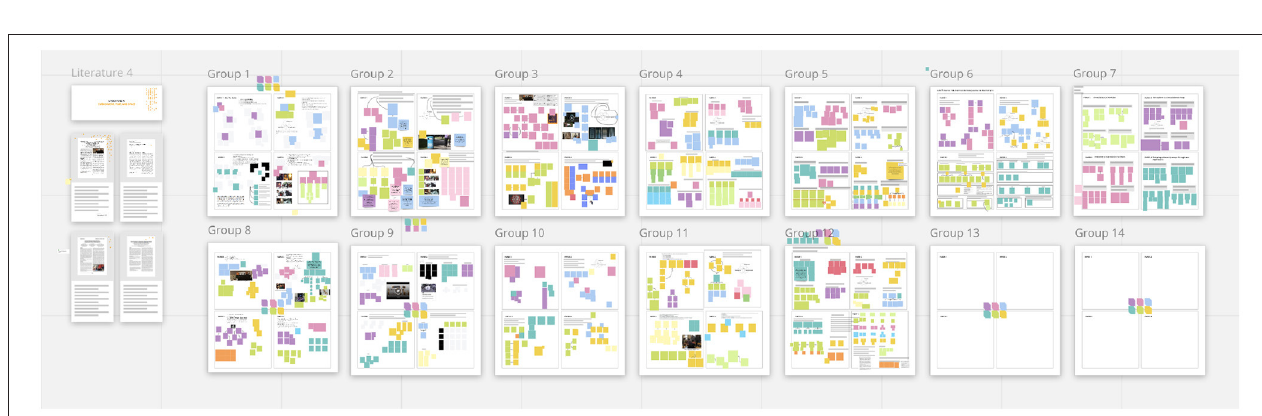
FIGURE 8 | A screenshot of the Miro board section dedicated to a literature session.To the left, the literature and respective dot voting (the students were prompted to vote on their favorite piece each week to facilitate the choice of literature for the next round of the course), and on the right a collection of boards filled by the students on each of the papers. Two empty group boards can also be